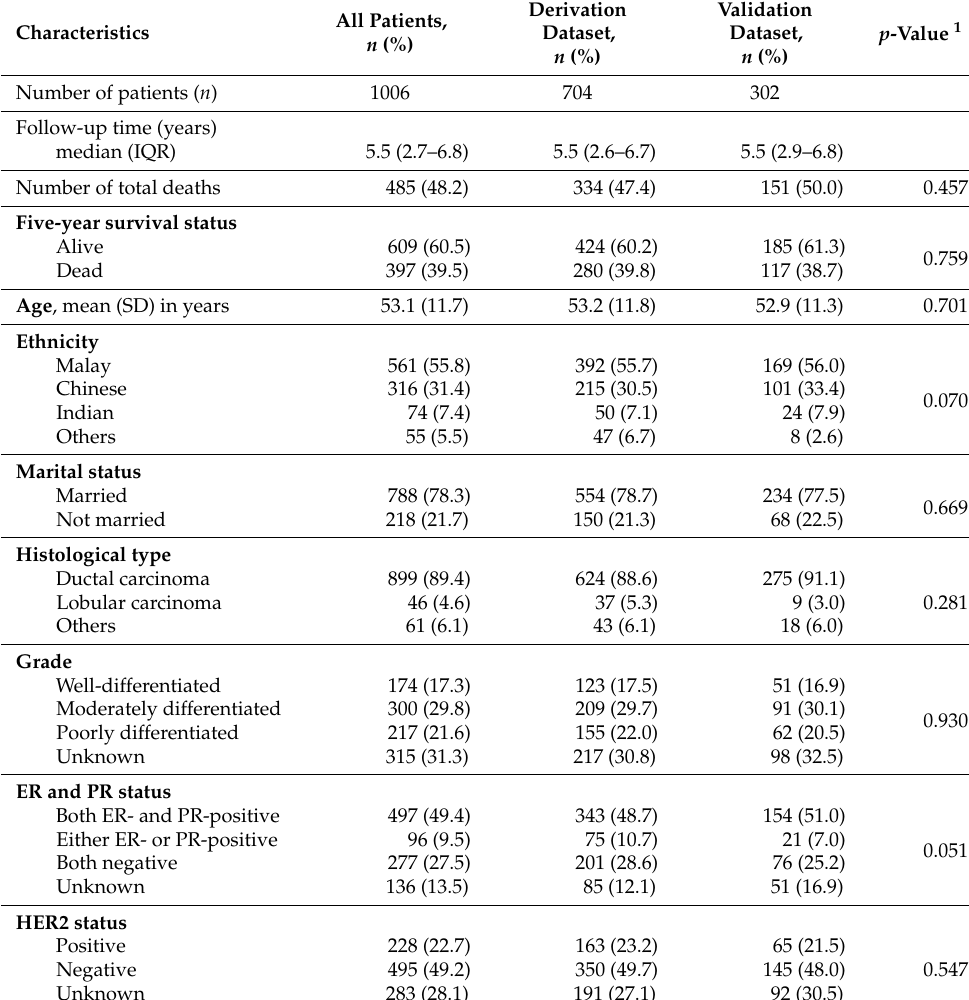
Table 1. Descriptive characteristics of women with breast cancer included for analysis, 2012–2016 ( n =